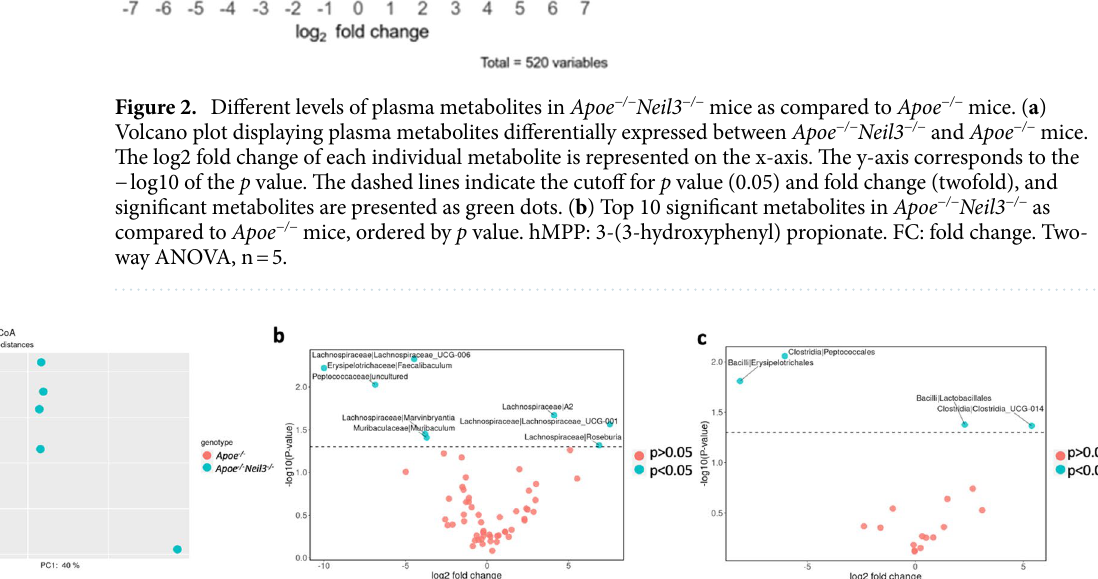
Figure 3. Significant differences in gut microbiota between Apoe −/− Neil3 −/− and Apoe −/− mice. ( a ) Bacterial beta diversity represented by Principal Coordinate Analysis (PCoA) plot, showing the distance of colonic microbial communities in Apoe −/− Neil3 −/− as compared to Apoe −/− mice (permutational multivariate analysis of variance, p = 0.02). Red dots, Apoe −/− mice; blue dots, Apoe −/− Neil3 −/− mice. ( b ) Significant differences (blue dots, p < 0.05) in the intestinal microbiota of Apoe −/− Neil3 −/− mice as compared to Apoe −/− mice (genus level, Aldex2). ( c ) Significant differences (blue dots, p < 0.05) in the intestinal microbiota of Apoe −/− Neil3 −/− mice as compared to Apoe −/− mice (order level, Aldex2). n =